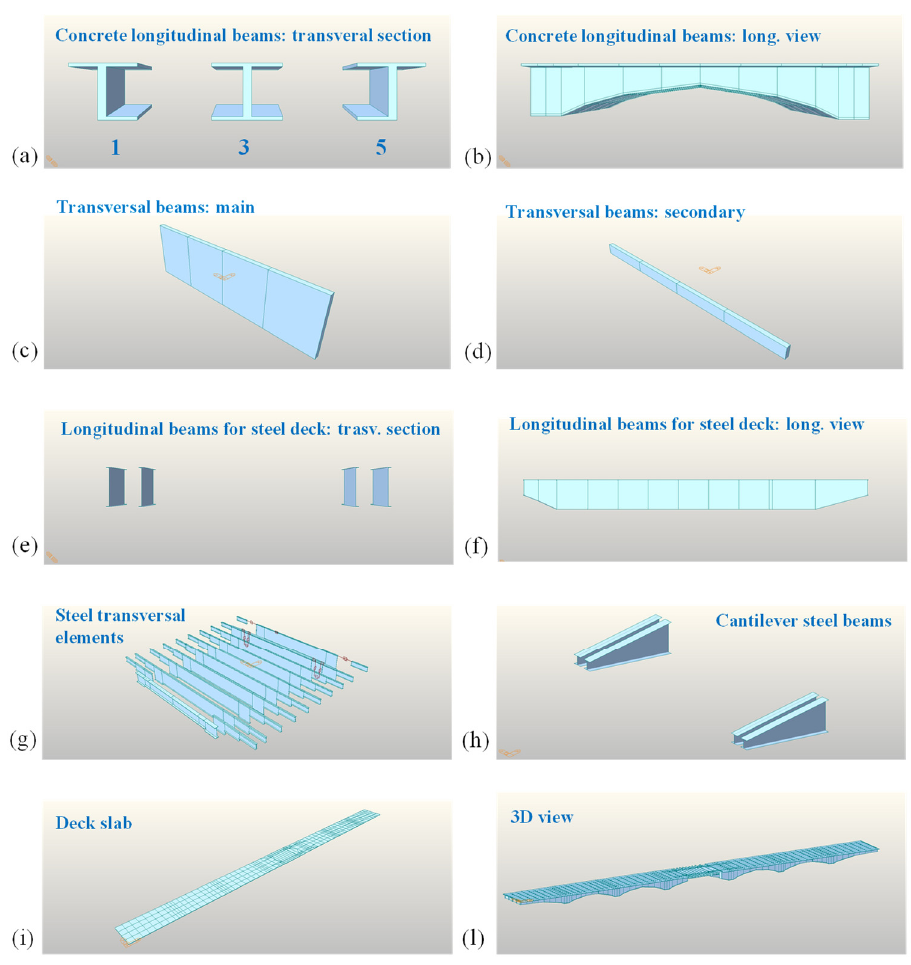
Figure 13. Representation of some important model elements: concrete longitudinal beams: ( a ) transversal section and ( b ) longitudinal view. Transversal beams: ( c ) main and ( d ) secondary. Longitudinal beams for the steel deck: ( e ) transversal and ( f ) longitudinal section; ( g ) steel transversal elements; ( h ) cantilever steel beams; ( i ) deck slab; ( l ) model 3D view.